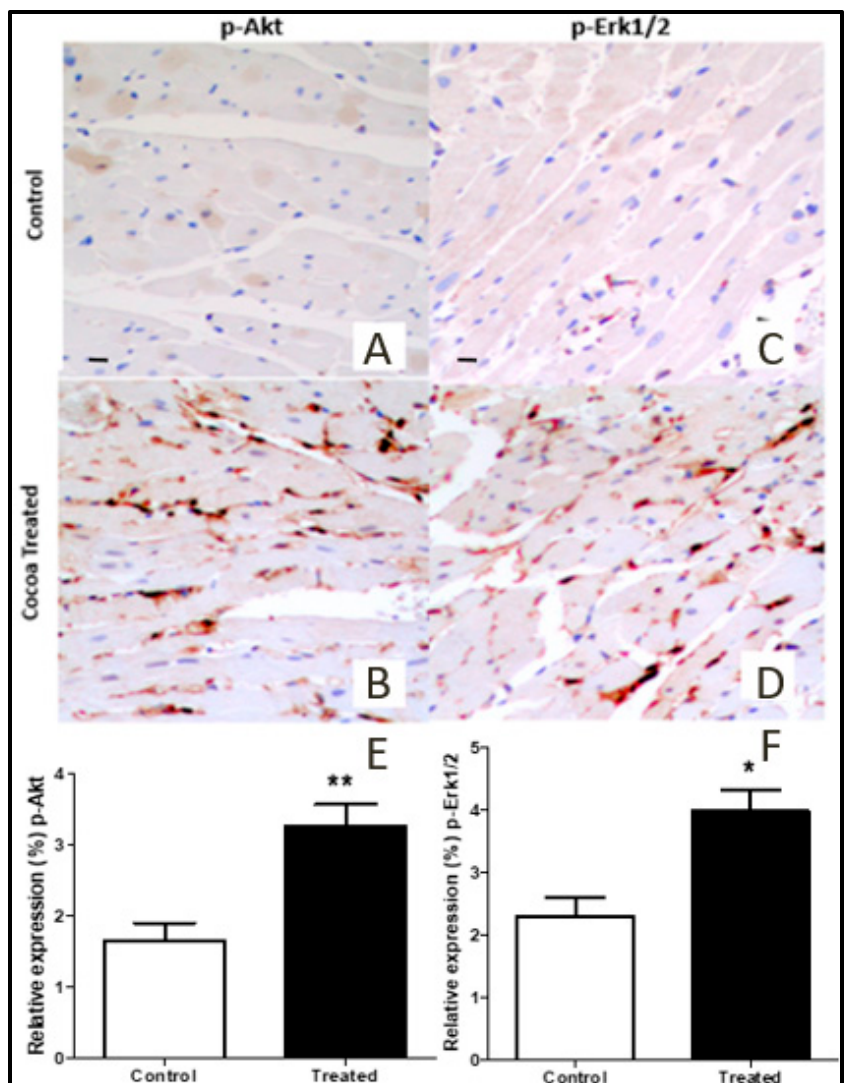
Figure 5. Immunohistochemical labeling of p-Akt (A, B, E) and p-Erk1/2 (C, D, F) in cocoa-treated rat